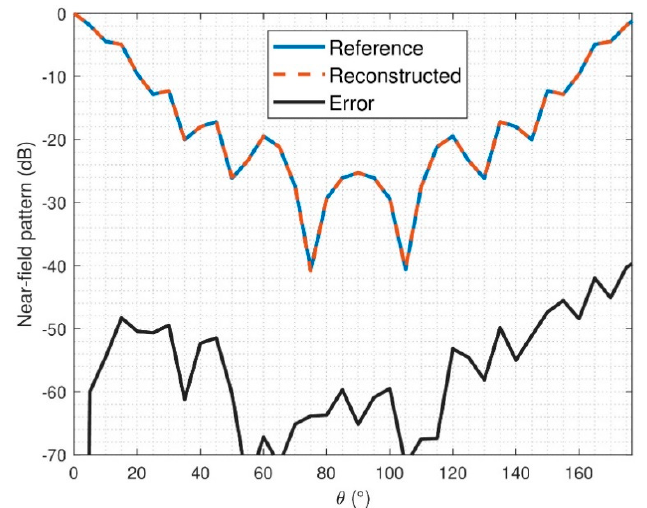
Figure 14. NF comparison of reference and retrieved electric-field for noisy simulation, E ϕ , ϕ = 0 ◦ . The mean FF error of the reconstructed field is − 72.2 dB and − 73.4 dB for E ϕ